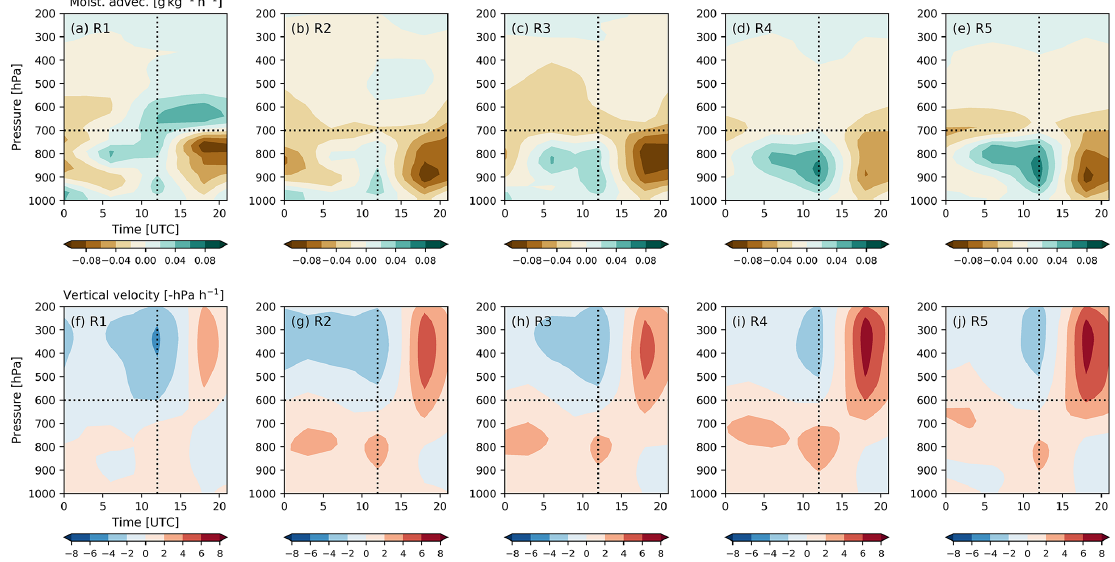
Figure 7. Composite diurnal (UTC) large-scale SCM variational forcing dataset (VARANAL) fields for (a–e) regime breakdowns of the horizontal moisture advection (green signifies positive moisture advection) and (f–j) large-scale background vertical velocity (red signifies upward vertical motion). 12:00UTC columns and 600hPa (f–j) and 700hPa (a–e) levels are highlighted as dotted